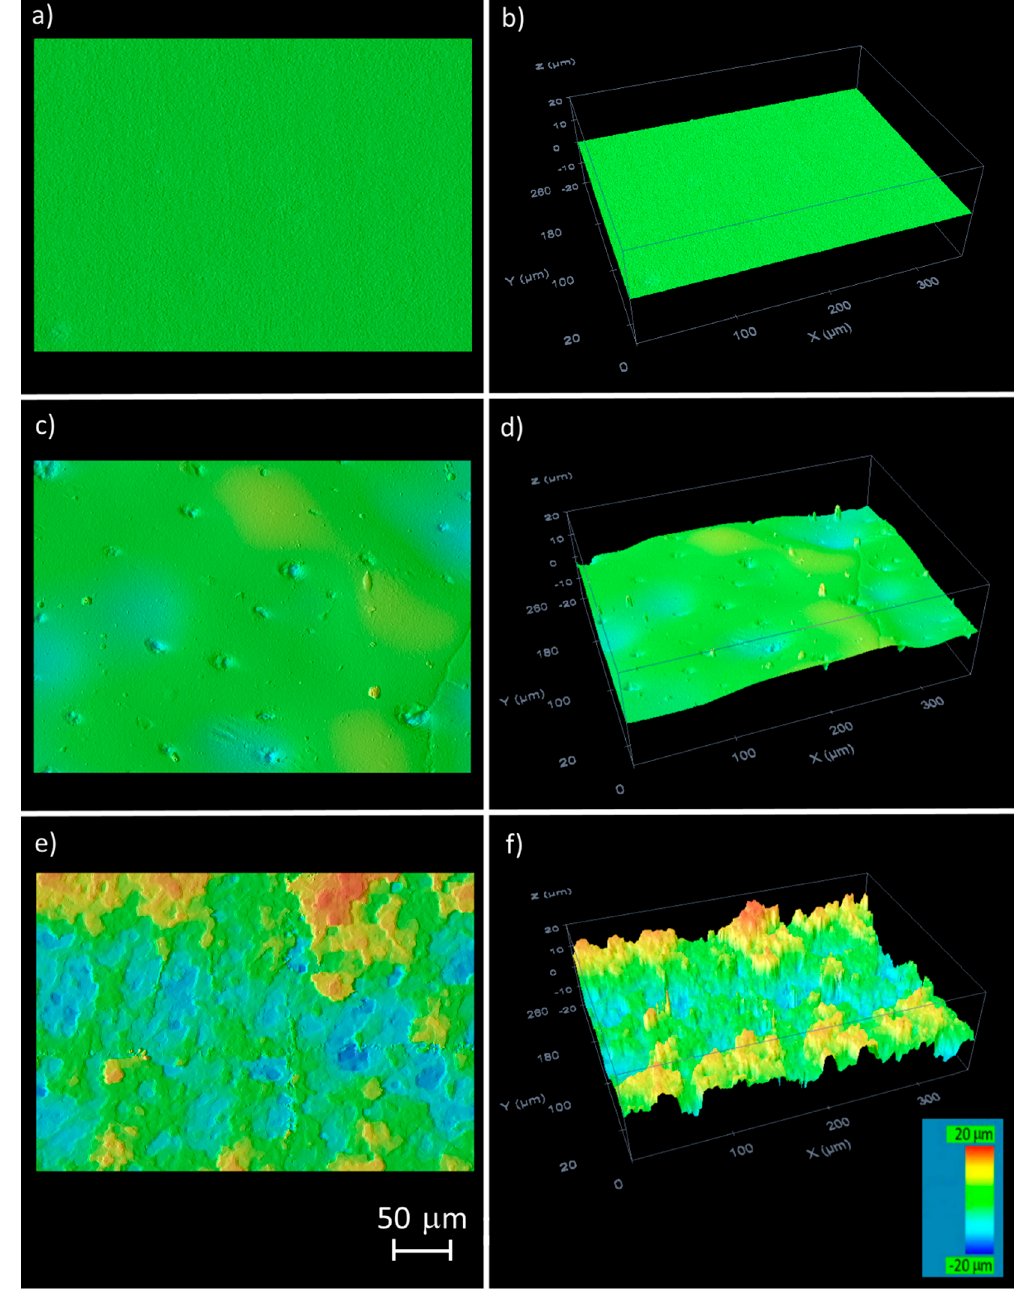
Figure 1 . Topographical images of the ABS surface roughness observed by confocal microscopy: ( a , b ) before laser irradiation; ( c , d ) after green laser irradiation in focus; ( e , f ) after green laser irradiation 0.8 mm out of focus.